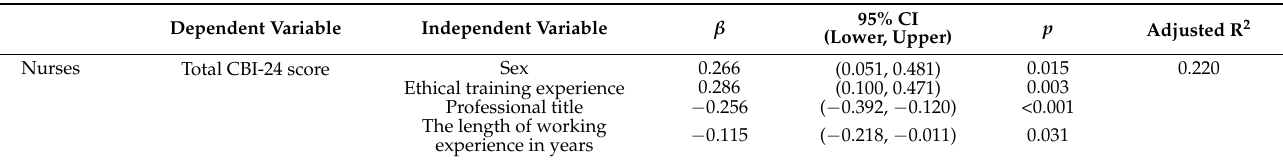
Table 5. Multiple linear regression analysis of the influencing factors of caring behaviors assessed by nurses and